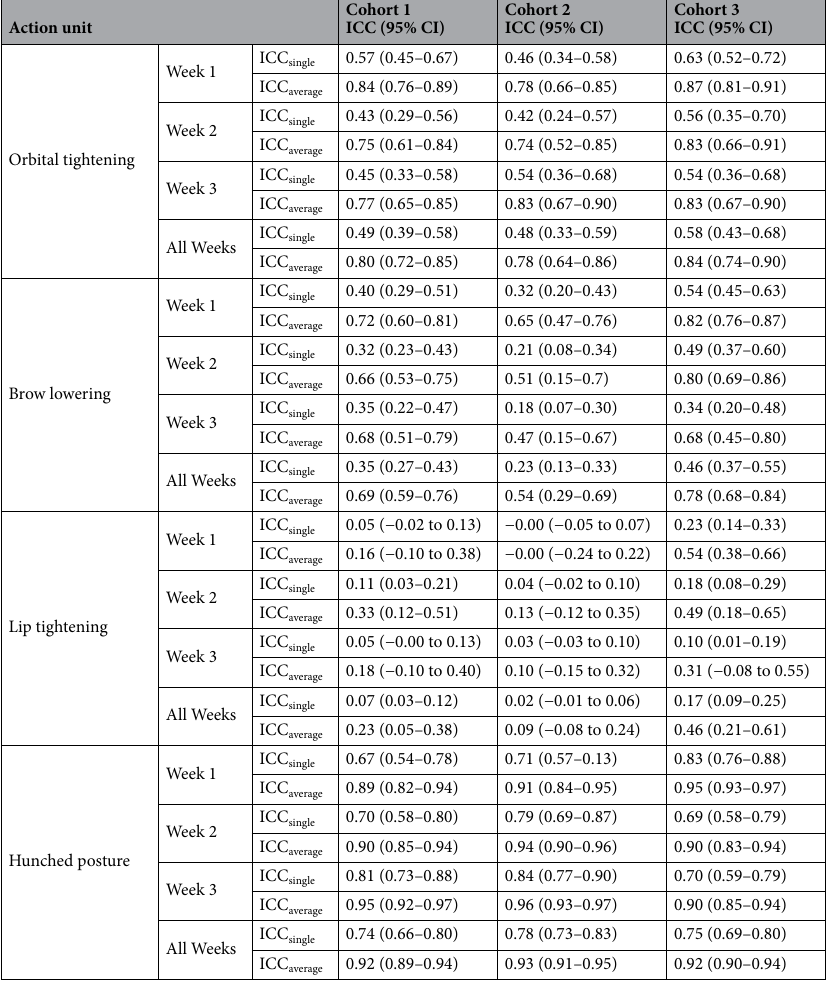
Table 3. Inter-observer reliability of CMGS scores across three cohorts from 12 raters. Intraclass correlation coefficient (ICC) estimates with respective 95% confidence intervals (95% CI) were calculated using a two–way random effects model for absolute agreement on CGMS scores based on single (ICC single ) and average (ICC average ) measures (of 4 raters per cohort, total of 12 raters). The interpretation of ICC values was based ICC single as follows: < 0.5 = poor reliability, 0.5–0.75 = moderate reliability, 0.75–0.9 = good reliability, and > 0.9 = excellent reliability 36